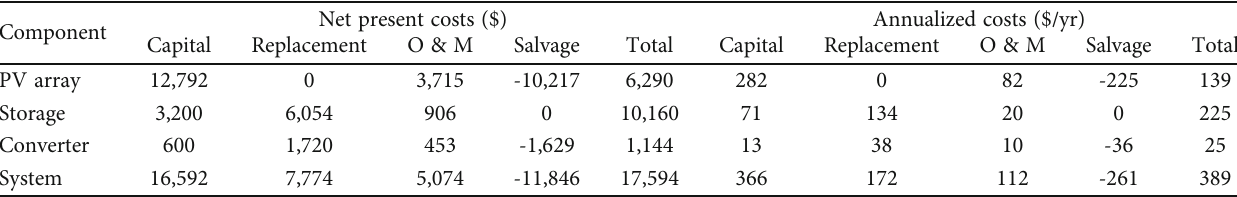
Table 4: Present worth and annualized value of all costs over 20 years.